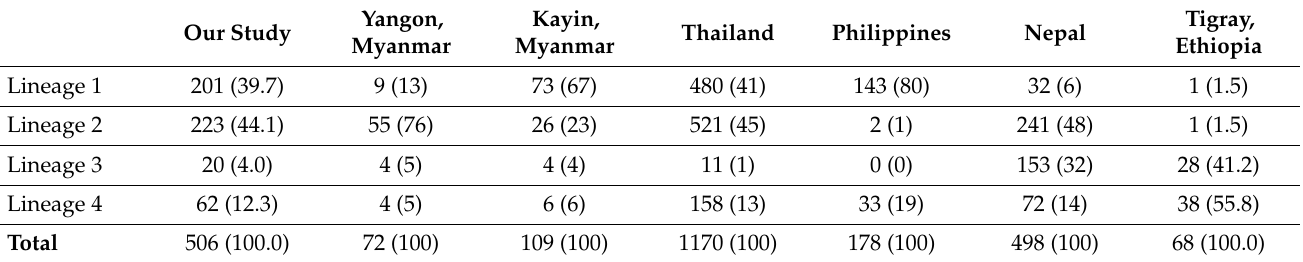
Table 7. N (%) of Mtb lineages according to our study and other